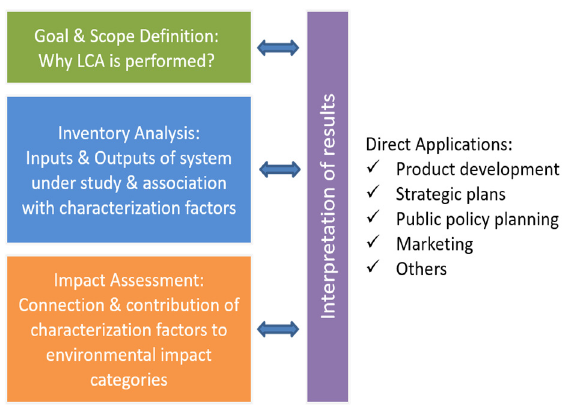
Figure 2. LCA stages as described in ISO 14040 standard.